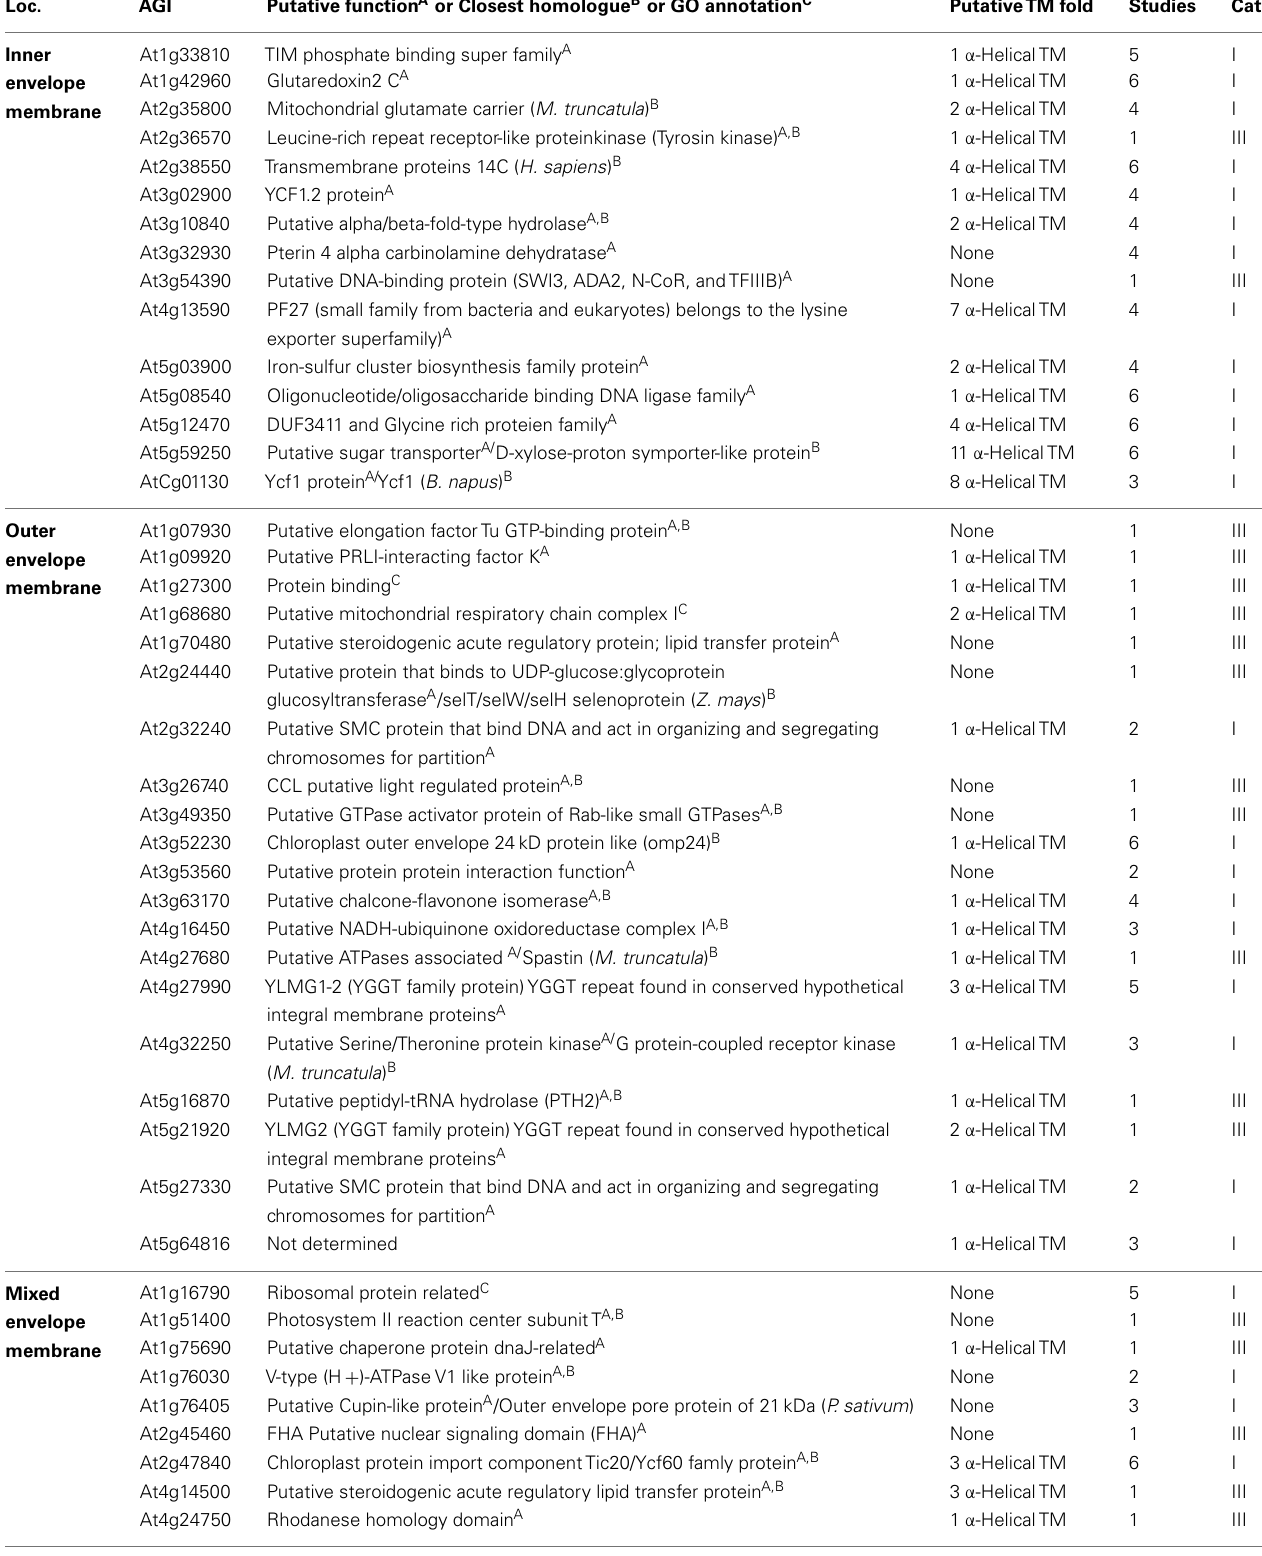
Table 6 | Proteins from Category I and III with unknown function.